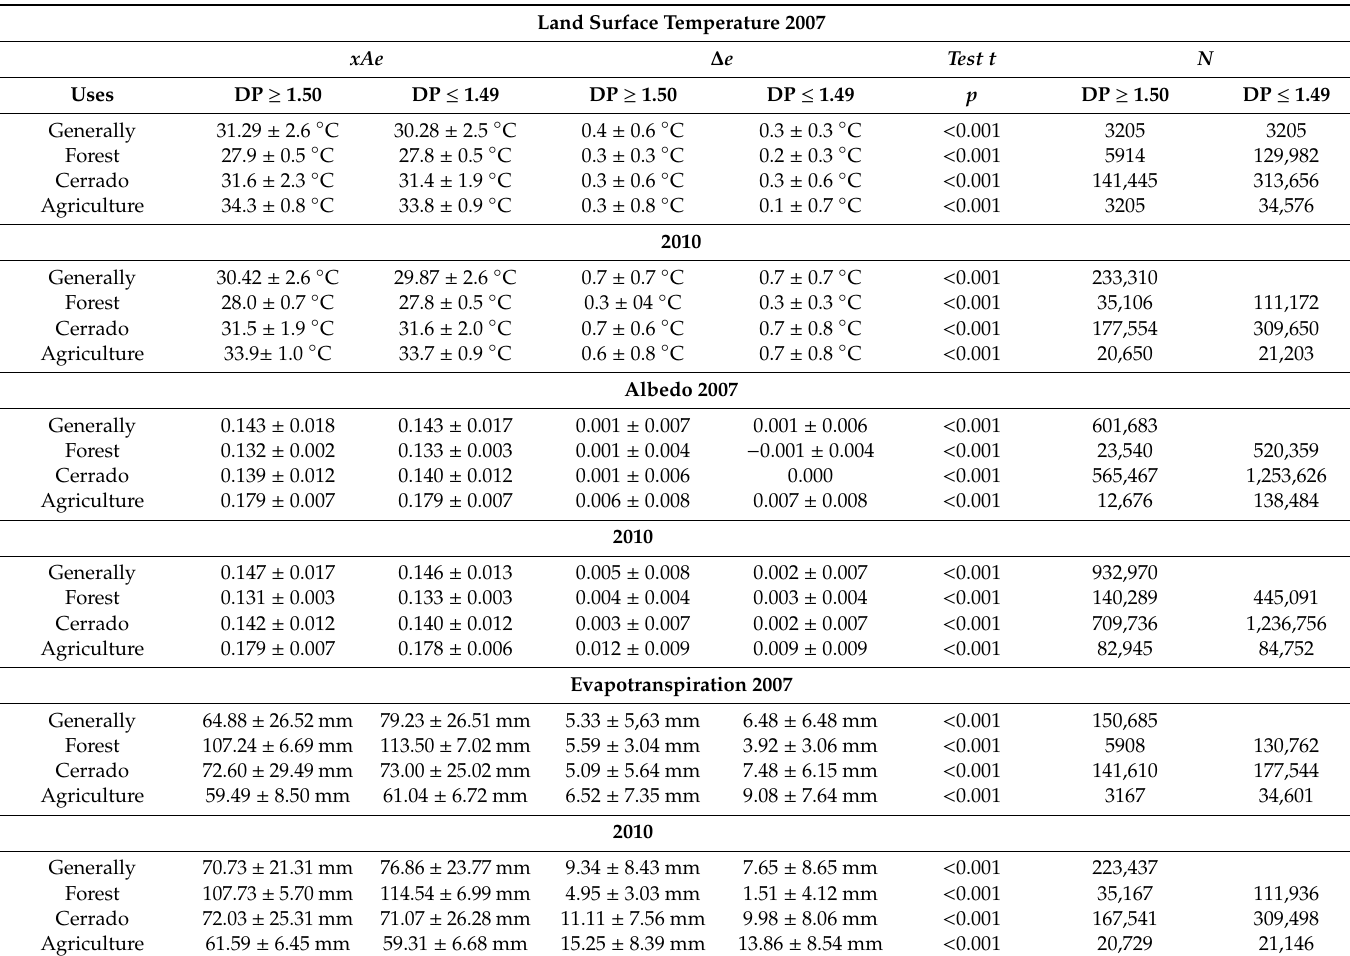
Table A2. Parameters used to evaluate the variation in the evapotranspiration (ET), land surface temperature (LST), and albedo between years of extreme drought and normal years in the three principal types of land cover (forest, savanna, and cropland) in the Brazilian state of Mato